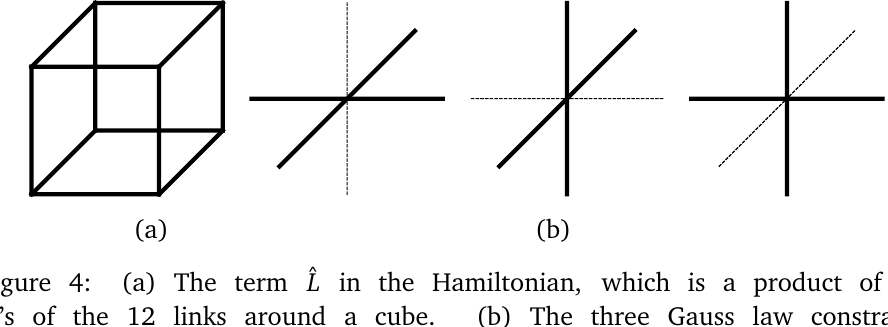
Figure 4: (a) The term ˆ L in the Hamiltonian, which is a product of the ˆ U ’s of the 12 links around a cube. (b) The three Gauss law constraints ˆ G [ x y ] z = ˆ G [ zx ] y = ˆ G [ yz ] x = 1, which are products of the ˆ V ’s on the links. The solid lines stand for ˆ U and ˆ V on the link in (a) and (b), respectively. We suppress the orientation of these link